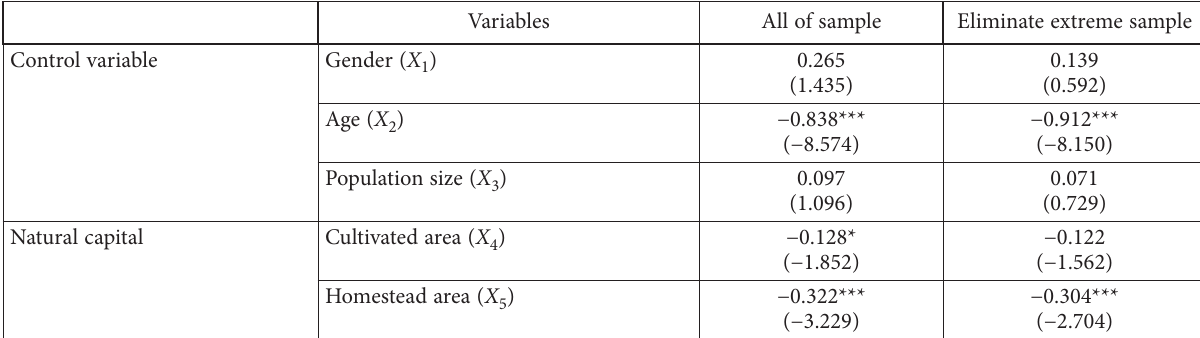
Table 5. Result of pooled